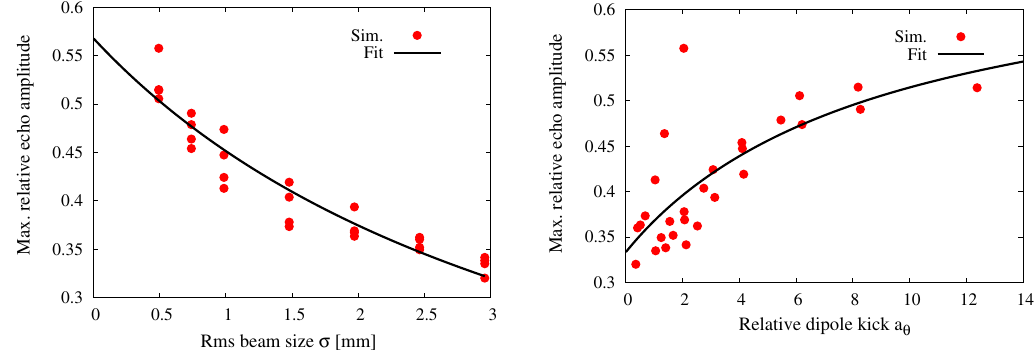
FIG. 8. Maximum relative echo amplitude A plot in Fig. 8 shows simulation results for A function of the initial beam size σ 0 , while the right plot shows A as a function of a θ . We find that A max function of σ 0 is best fit by a functional form